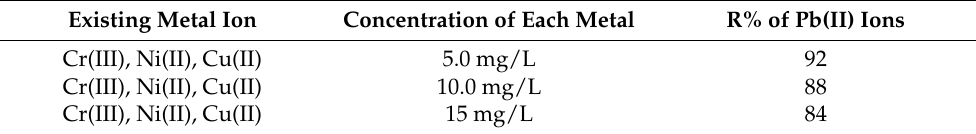
Table 5. Comparison between the maximum uptake capacity and the optimum conditions for various adsorbents.